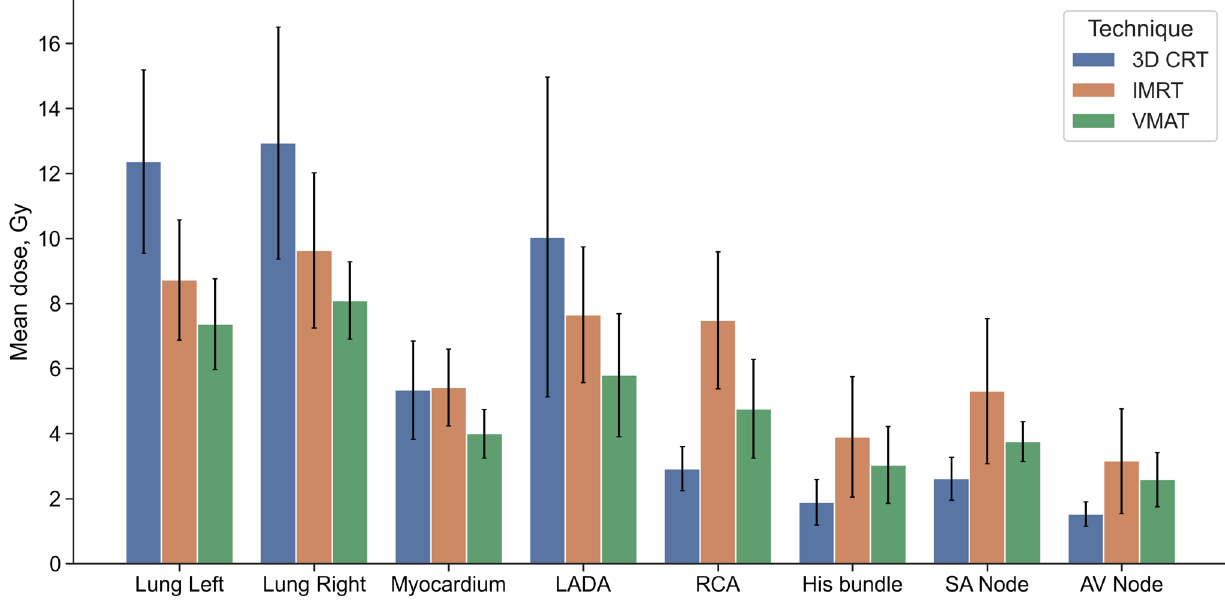
Fig. 4 Mean dose with SD in the OARs of 3D CRT, IMRT and VMAT